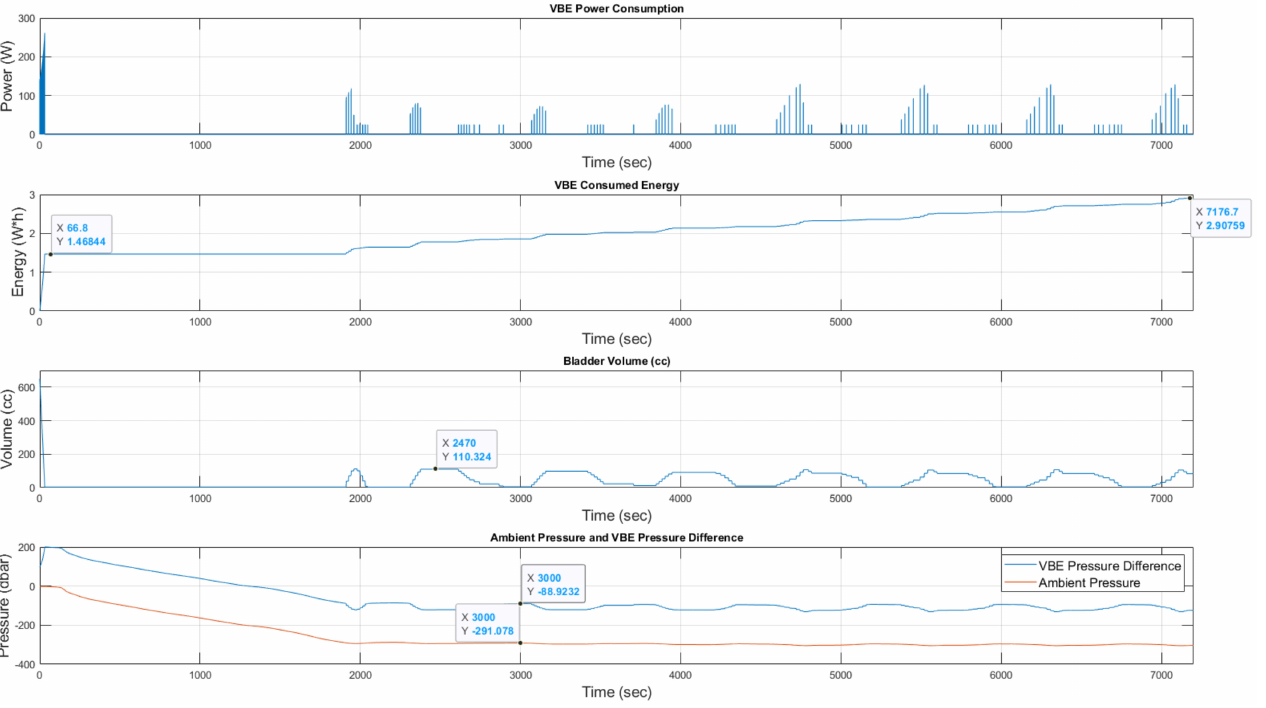
Figure 15. Simulink power simulation #2: pressure assistance; HPA minimum pressure equal 10 bar